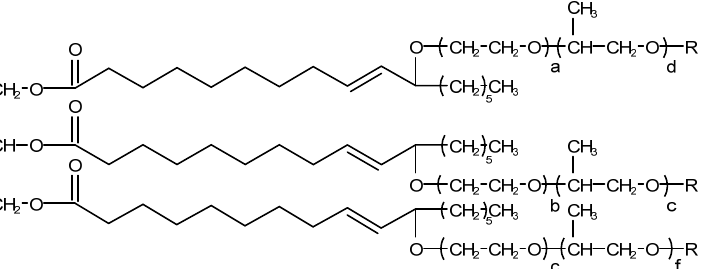
Figure 12. Structure of castor oil polyoxyethylene polyoxylactone oleate (R is selected from H, –OC(CH 2 ) 7 CH=CH(CH 2 ) 7 CH 3 at least one R group is –OC(CH 2 ) 7 CH=CH(CH 2 ) 7 CH 3 , a + b + c = 0–40 and d + e + f = 0–20.).